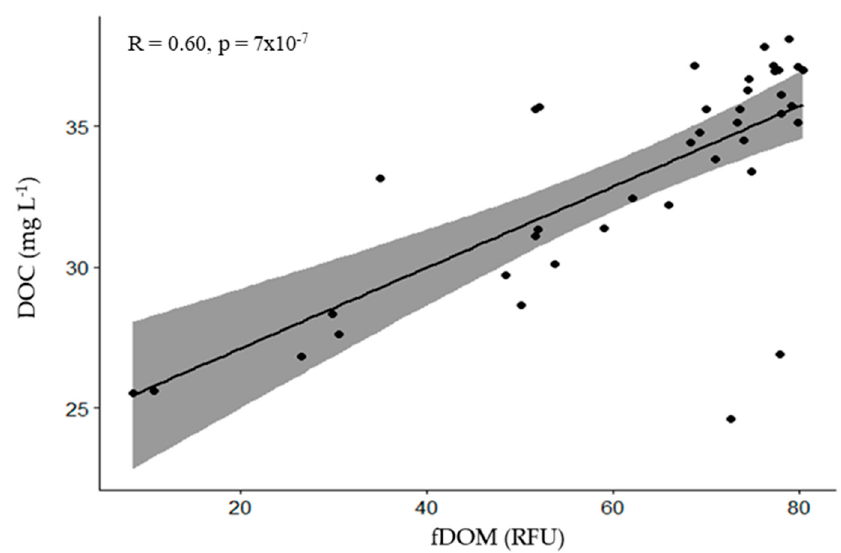
Figure 10. A Spearman’s rank correlation was run fDOM and DOC concentrations collected on 22 January at 20 points across the study site at low and high tide. Spearman correlation ρ was measured at 0.69 and indicates a moderate relationship between the two variables.